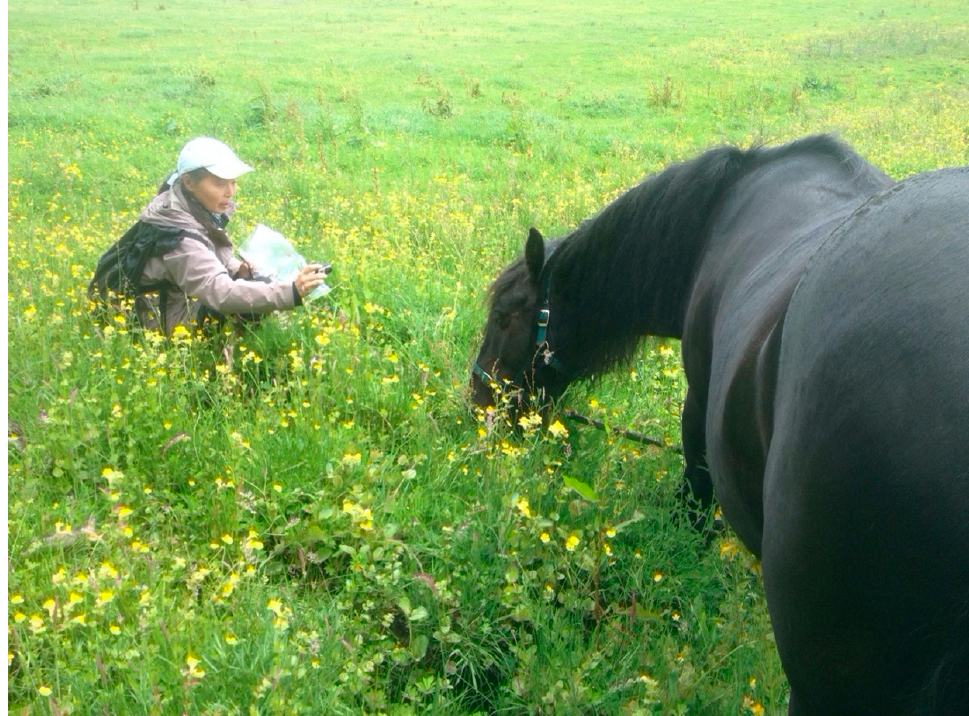
Figure 4. Goto and Darkness during collecting specimens of ‘What he likes’ (Collins & Goto Studio 2018).